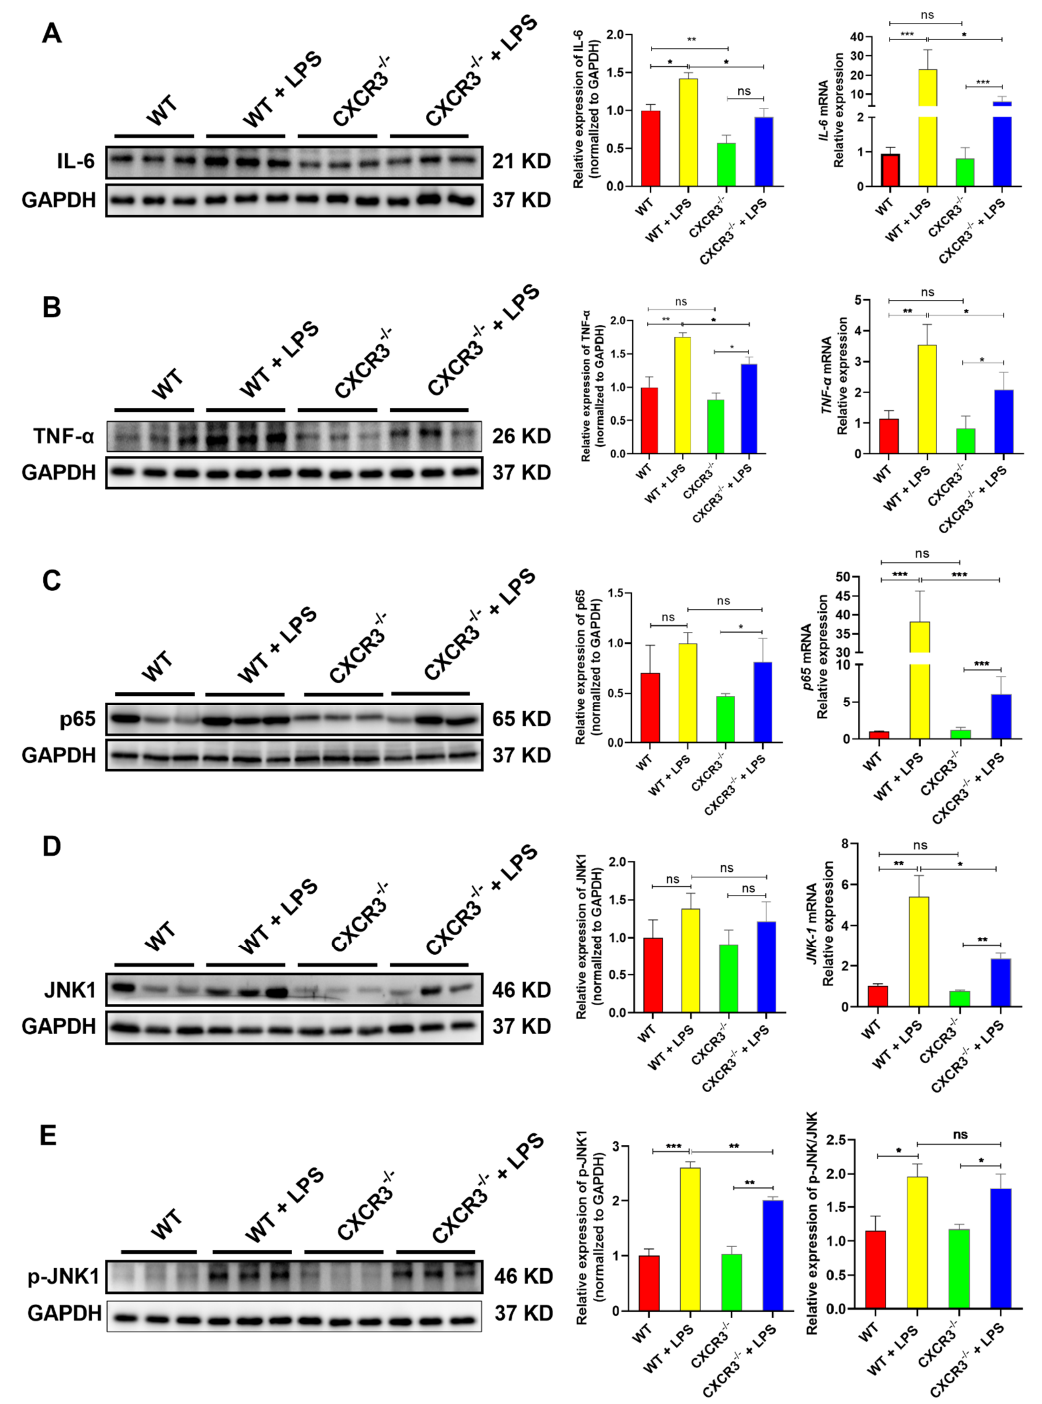
Figure 3. CXCR3 knockout inhibits the activation of the NF- κ B signaling pathway in the mouse intestine. C57BL/6J WT mice and CXCR3 − / − mice were intraperitoneally injected with LPS 10 mg/kg. After 24 h, the mice were sacrificed. The mRNA and protein of jejunum tissue were extracted. qPCR and Western Blot assays were used to investigate the mRNA and protein expression of the NF- κ B signaling pathway. ( A ) IL-6 mRNA and protein expression. ( B ) TNF- α mRNA and protein expression. ( C ) p65 mRNA and protein expression. ( D ) JNK1 mRNA and protein expression. ( E ) JNK1 phosphorylation. The protein optical density values were analyzed by Image J software. Values represent the mean ± SEM. of three independent experiments. Significant differences are represented by * p < 0.05, ** p < 0.01, *** p < 0.001, and ns (not